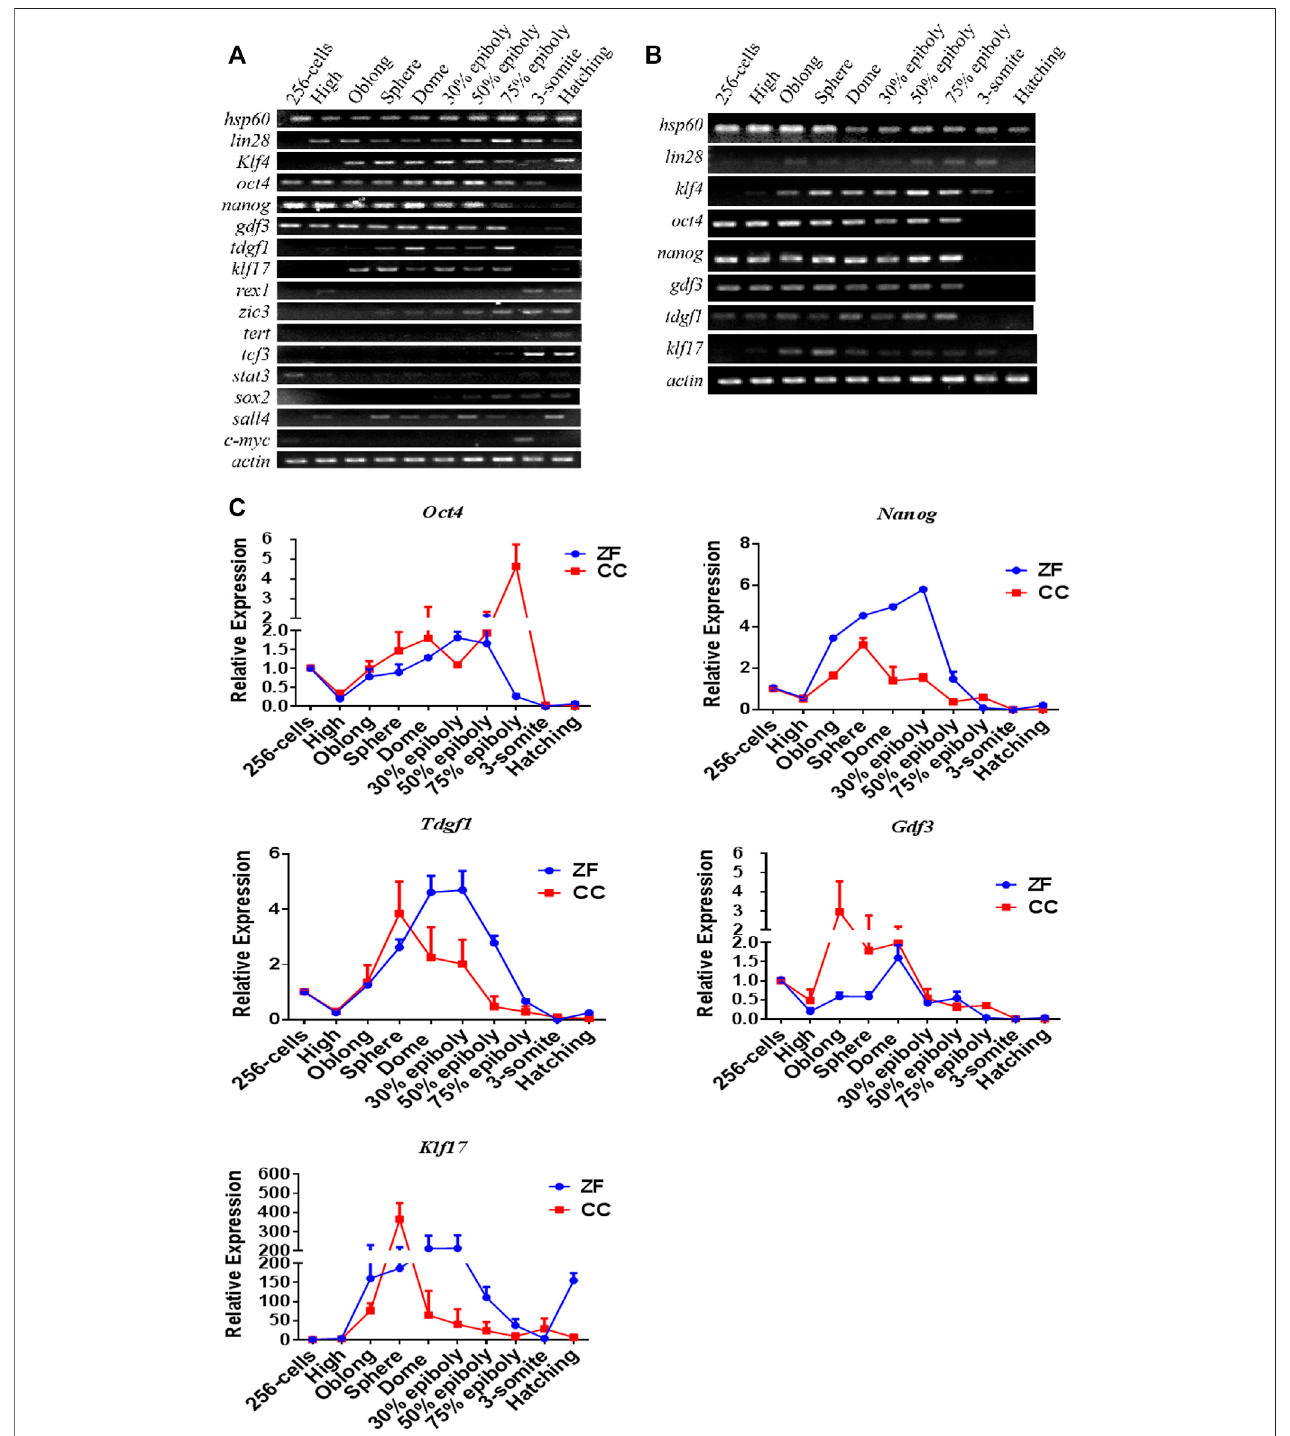
FIGURE 1 | RT-PCR and qRT-PCR analysis of candidate pluripotency genes in 10 stages of em[bryonic development of Zebra fi sh (ZF) and Crucian carp (CC). (A) RT-PCR analysis of 16 pluripotency-related genes in 10 stages of embryonic development of zebra fi sh. (B) RT-PCR analysis of eight pluripotency-related genes in 10 stages ofembryonic development ofcrucian carp. (C) qRT-PCRanalysisfor candidate pluripotency genes ( Nanog, Oct4, Tdgf1, Gdf3 and Klf17 ) through the 10stages ofZFandCCembryos.Itwasclearlyshowedthatthesefourgeneswereseemedtobemainlyexpressedinthepluripotentcellsofundifferentiatedembryos,butthe expressionwassigni fi cantlydecreasedorevenlostafterembryoniccelldifferentiation.Foreachgenedetected,the △ CTvaluewascalculatedfromtheaverageCTvalue of the independent housekeeping gene β -actin. For each sample, At least three independent experiments were done for these results.